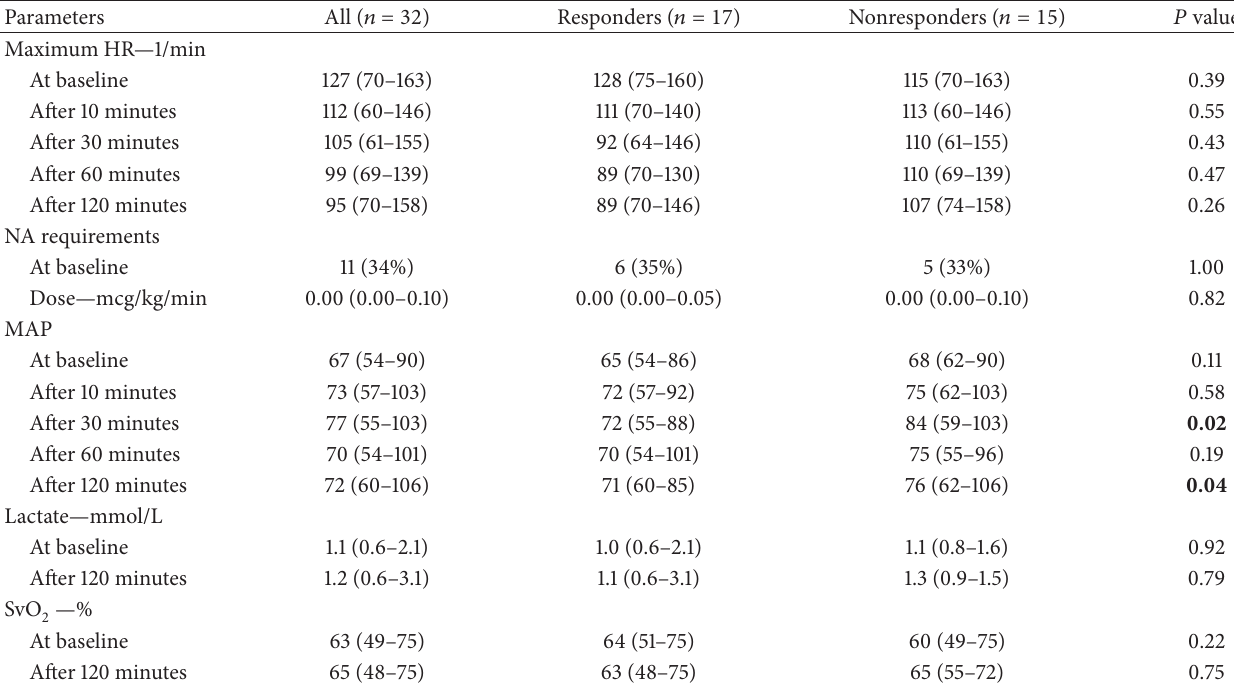
Table 3: Hemodynamic changes during treatment.